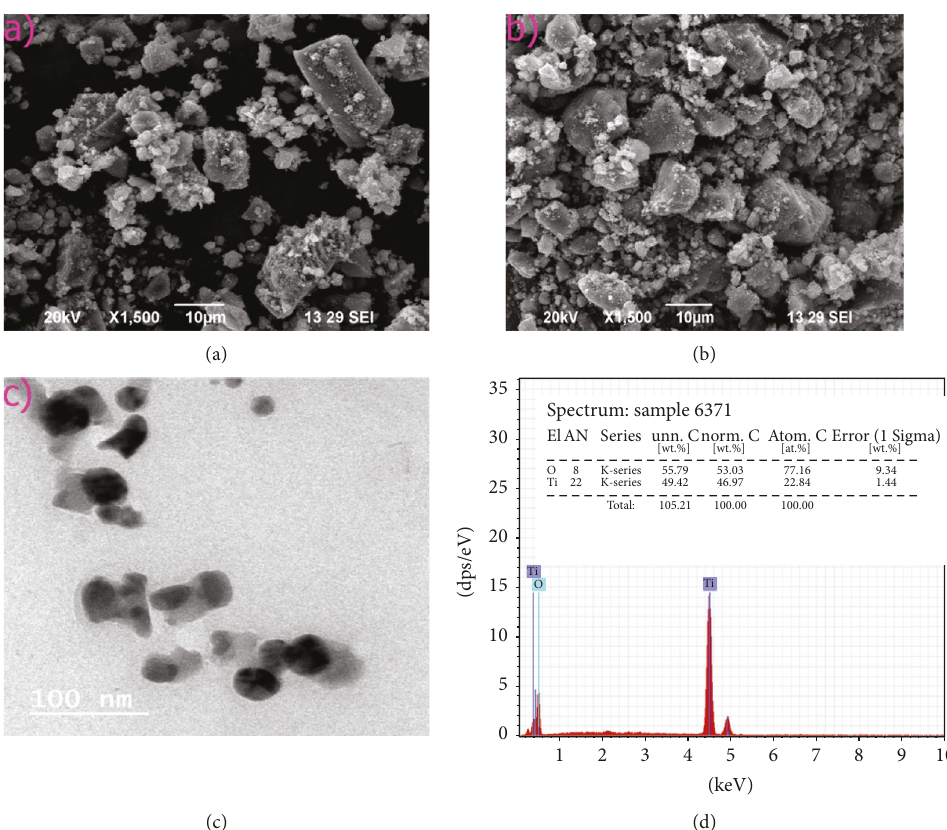
Figure 6: (a, b) SEM images ofTiO 2 NPs, (c) TEM micrograph of TiO 2 NPs, and (d) EDX spectra of the TiO 2 NPs.